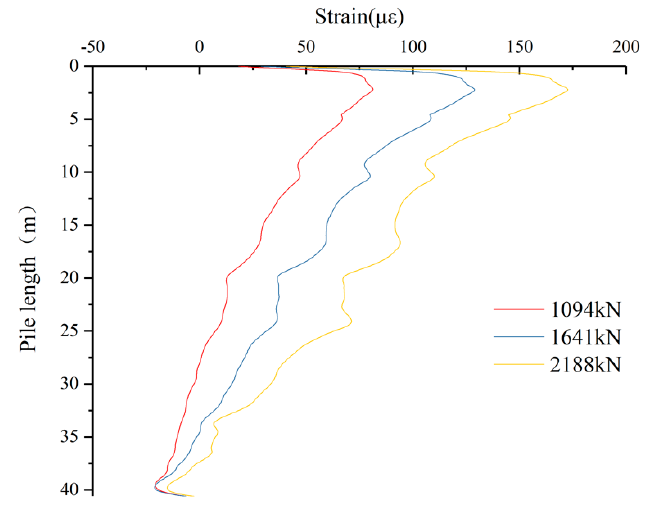
Figure 5. Translation mean method smoothing signal.